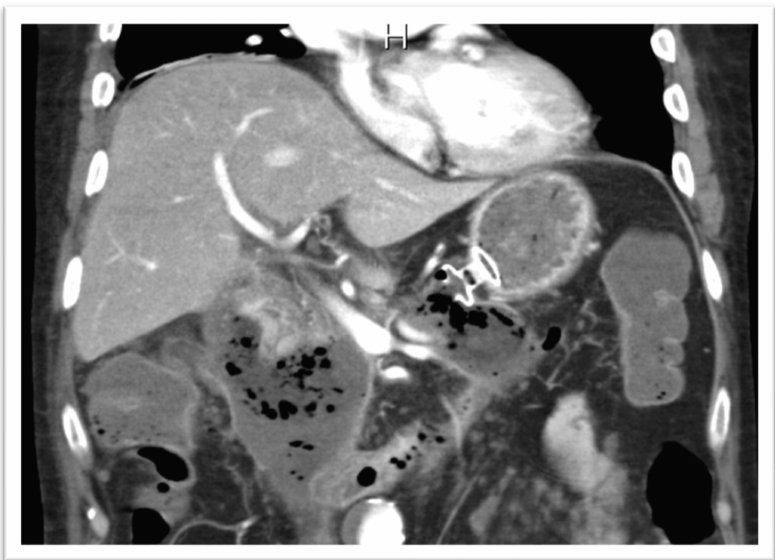
Figure 12. Lumen-apposing metal stent in the context of